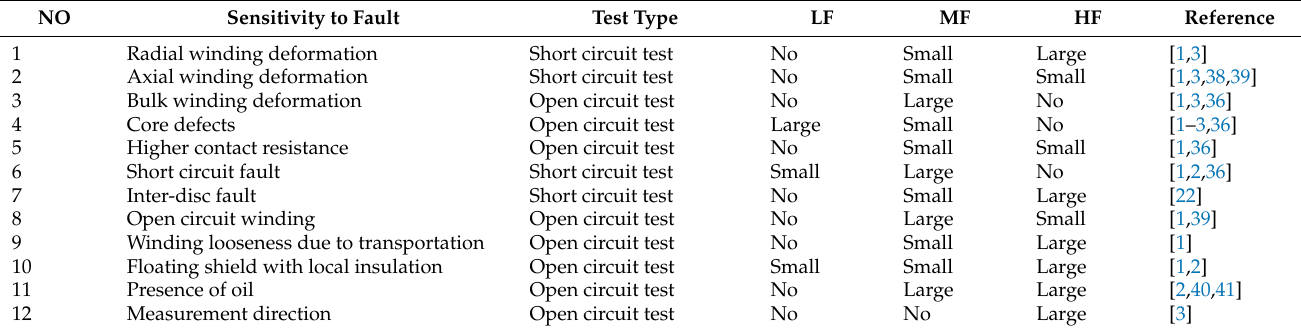
Table 3. Effect of various transformer conditions on three frequency regions of the FRA